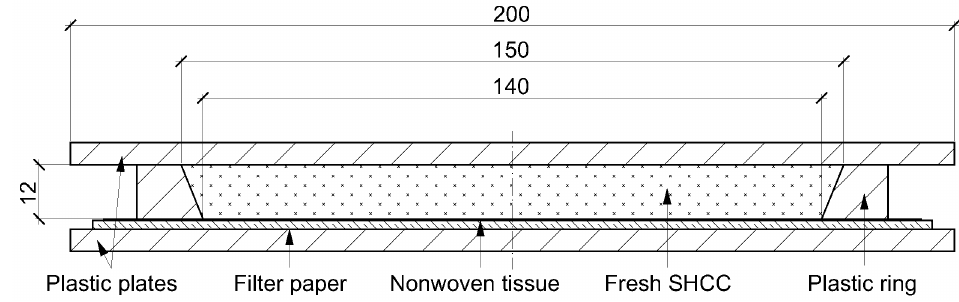
Figure 3. Setup of the water retention test.